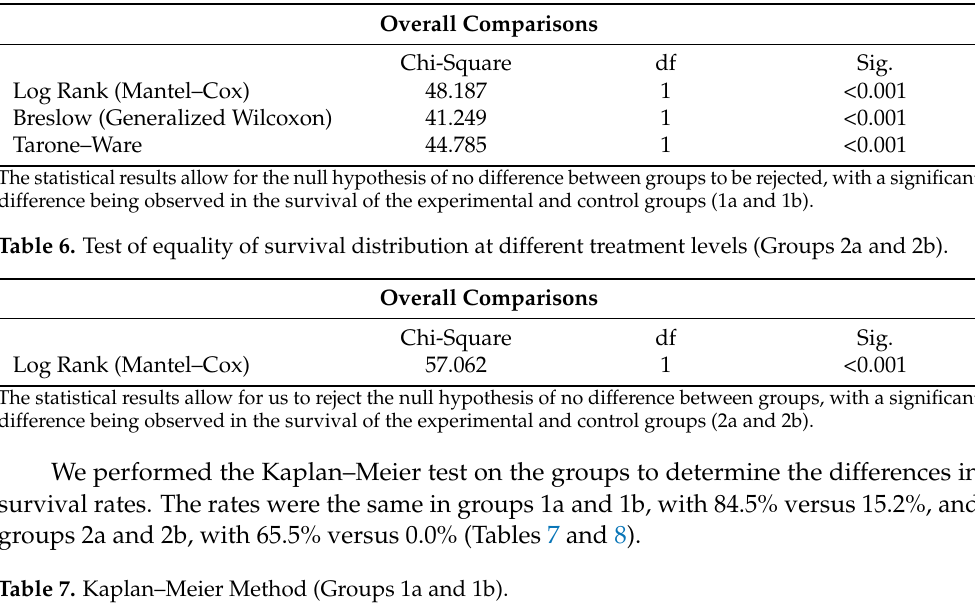
Table 5. Test of equality of survival distributions at different treatment levels (Groups 1a and 1b).